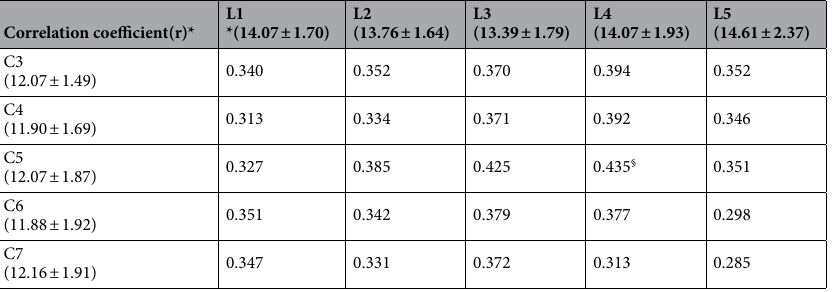
Table 1. Correlations between cervical canal and lumbar canal diameters. All cervical canal diameters from C3 to C7 were correlated with lumbar canal diameters at all segments. Particularly, the C5 canal diameter showed highest correlation with L4 canal diameter. All p value < 0.001, * unit : mm, § highest correlation coefficient.